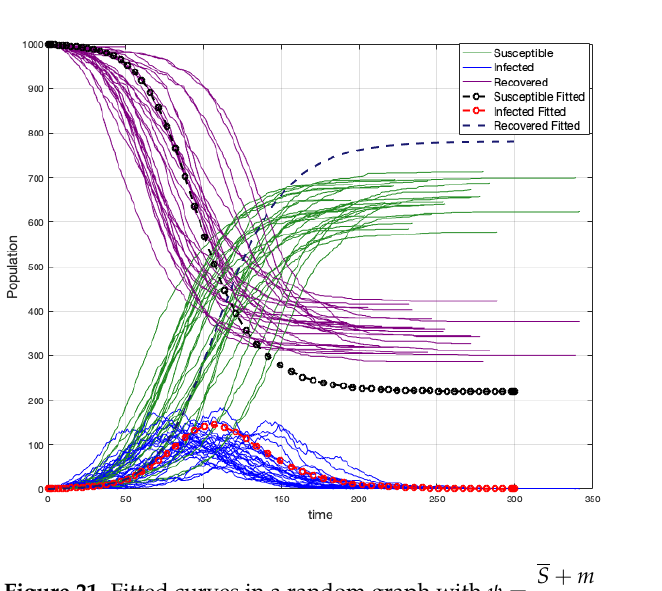
Figure 21. Fitted curves in a random graph with ψ =